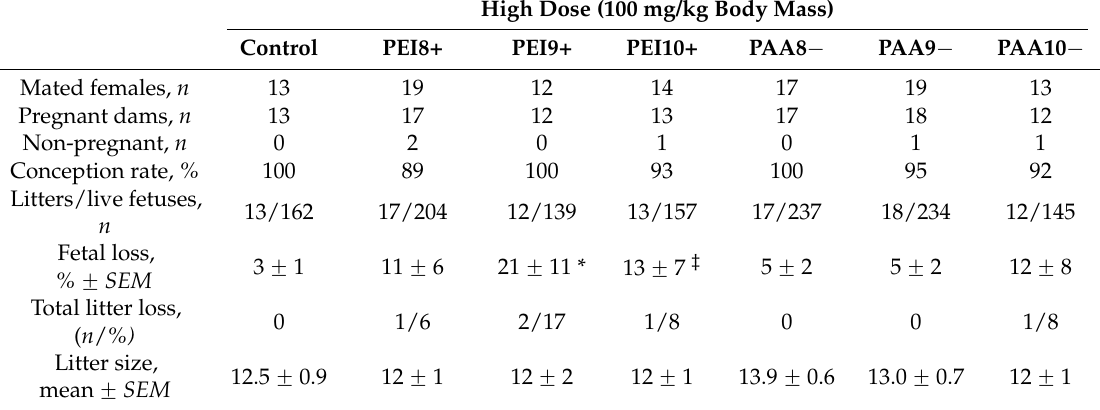
Table 6. Fertility indices for offspring exposed to 100 mg/kg of iron oxide NPs on GD 8, 9, or 10 in utero . Each treated mouse was mated to a control. * Significant difference between treatment group and the control ( p < 0.05). ‡ Trend between treatment and control at ( p < 0.1).